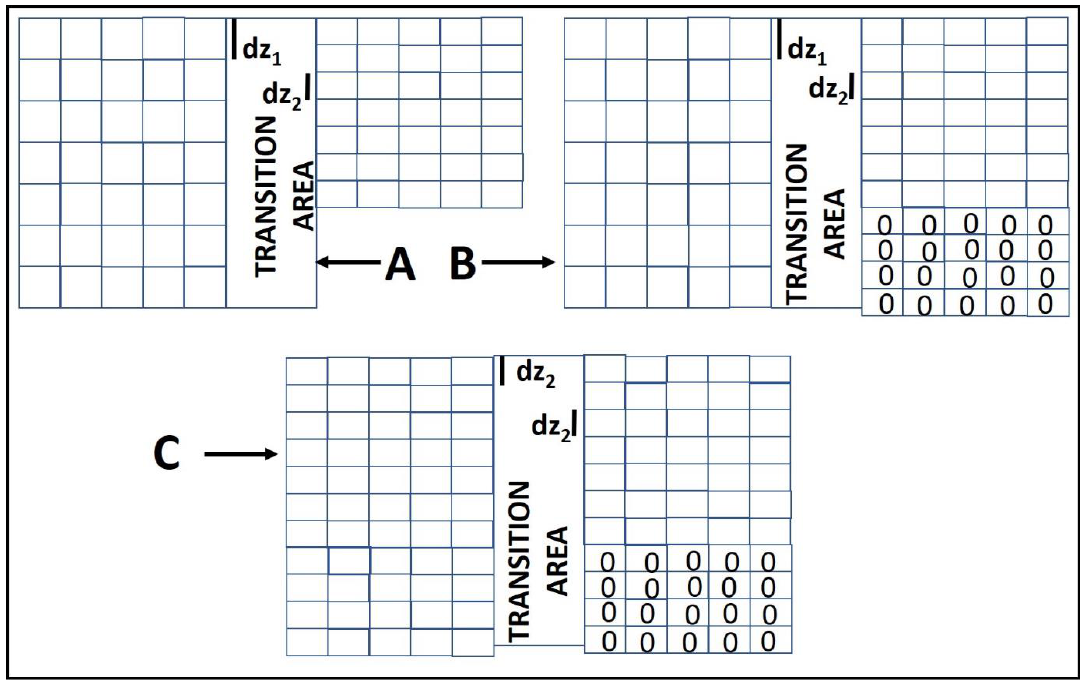
Figure 1. Pictorial synopsis for horizontal velocity transition: Image A represents the initial situation after separate time-depth conversions. Image B represents the situation after zero-padding of the area with slower propagation velocity. Image C shows the situation after resampling the part with faster propagation velocity.